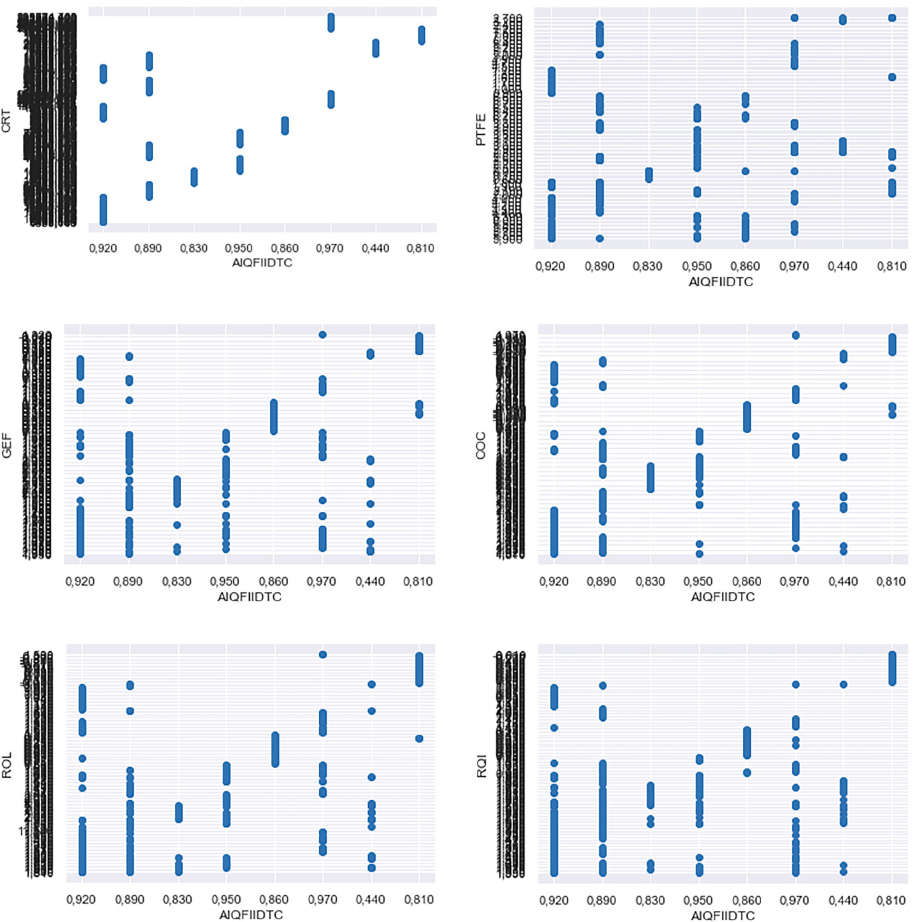
Figure 1. Scatter Plots regarding the correlation between double taxation conventions, tax compliance and tax evasion (source: own processing using Python 3.0